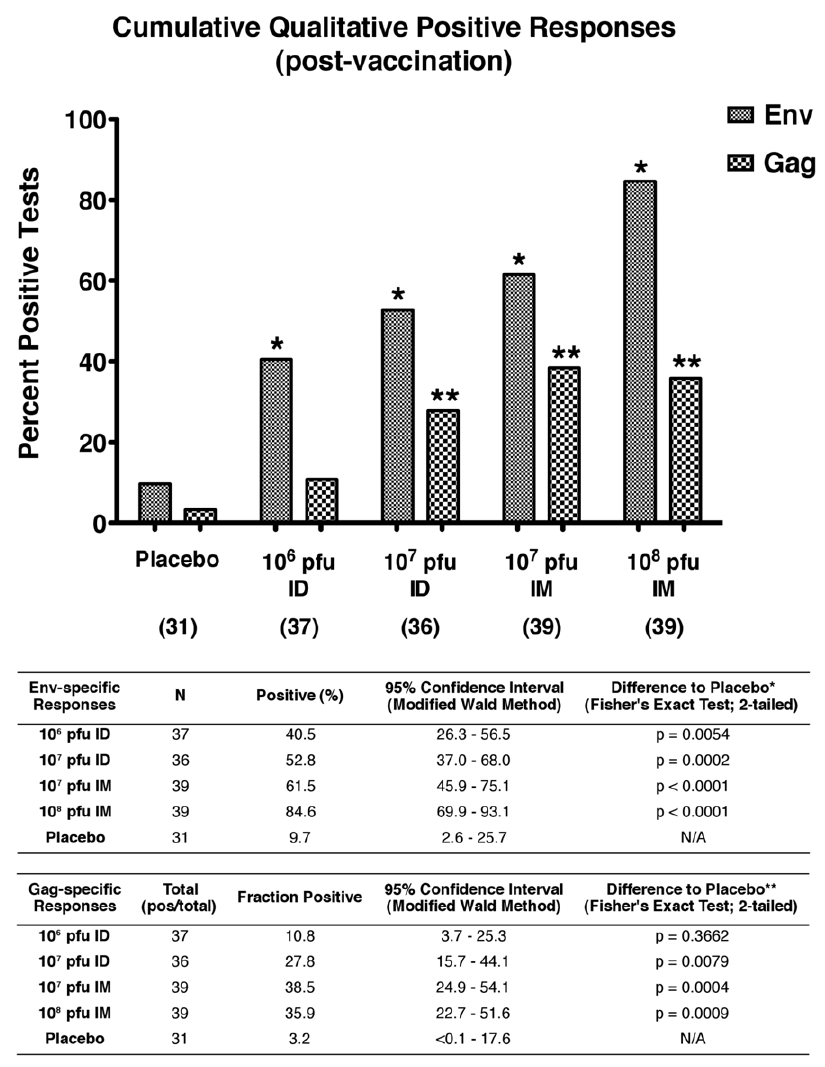
Figure 4. Cumulative analysis of all qualitative cellular immune response assays. The number of positive responders for HIV antigens (Env or Gag) in the 51 Cr-release, Elispot, lymphocyte proliferation and whole blood ICS assays was tallied for all groups and compared with the placebo recipients. The figure graphically displays the summed cumulative positive responders for each of the 4 assay platforms. The total number of tests performed in each group is denoted below the dose and route. The top and bottom tables summarize the statistical analyses for Env and Gag respectively.